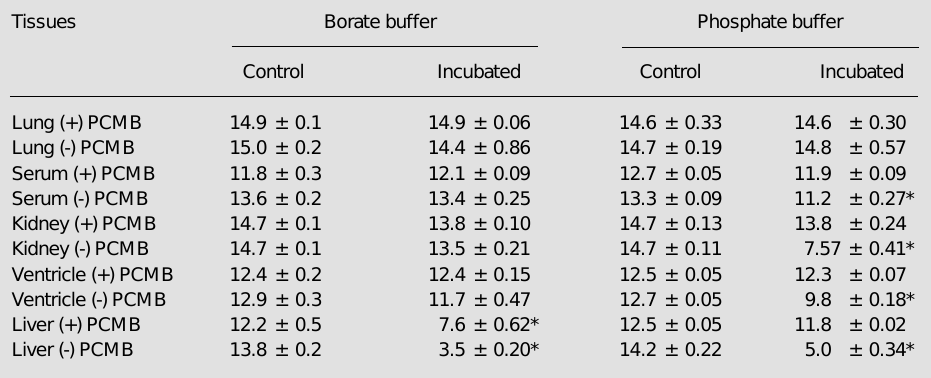
Table 2 - Effect of buffer and r -chloromercuribenzoic acid (PCMB) on the dipeptidase activity of tissue homogenates from Wistar rats. The homogenates (20 µl) and serum (10 µl) were incubated for 30 min with 62 nmol His-Leu in the presence and absence of 100 µM PCMB. Data indicate the relative fluorescence of the incubated product and the values obtained at time zero (control). Data represent the mean ± SD of three independent experiments. *P<0.01 compared to control (Student t